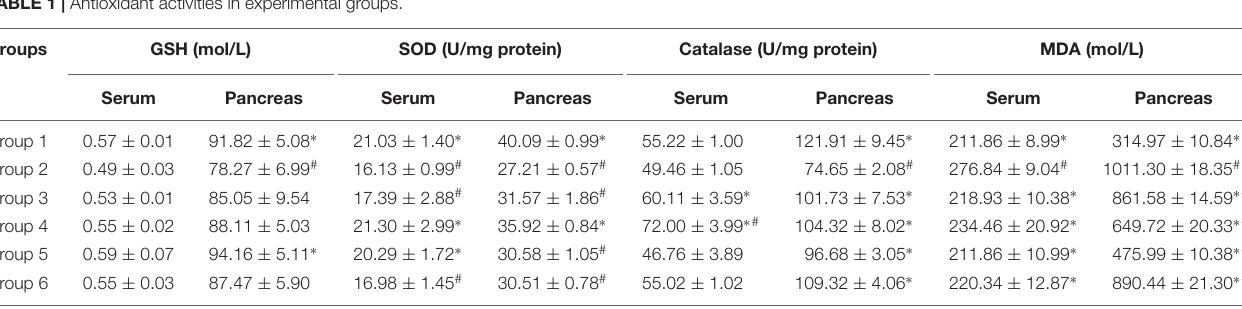
TABLE 1 | Antioxidant activities in experimental